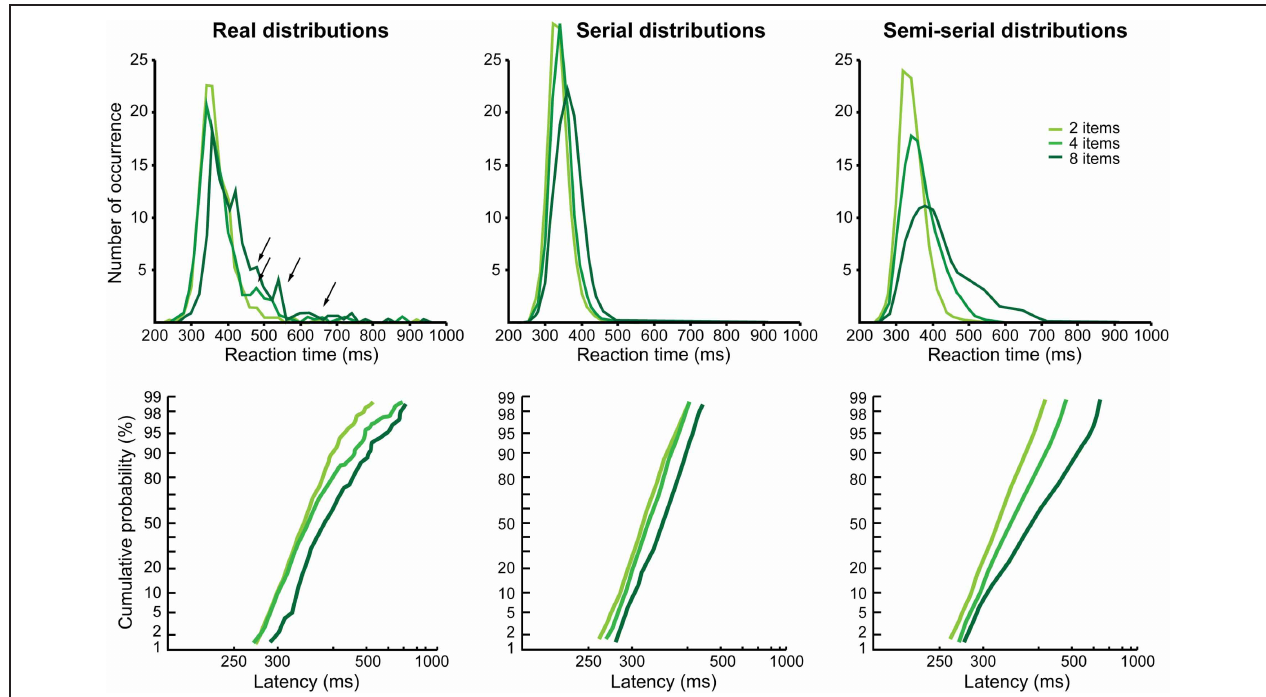
FIGURE 4 | Real and simulated reaction times distributions for the difficult feature search condition in Monkey G. On the left, the real distributions and their corresponding reciprobits are shown as a function of the number of items (same data as in Figure 3B , middle panel). Black arrows correspond to late reaction times bumps in the distributions that could correspond to re-exploration (see text and below). The middle distributions correspond to a simulation of a purely serial search (the easy feature search distribution of Monkey G is used as the distribution for one attentional shift and, as the number of objects increases, we add the same distribution shifted by the timing we evaluated for a single attentional shift, estimated thanks to the slope